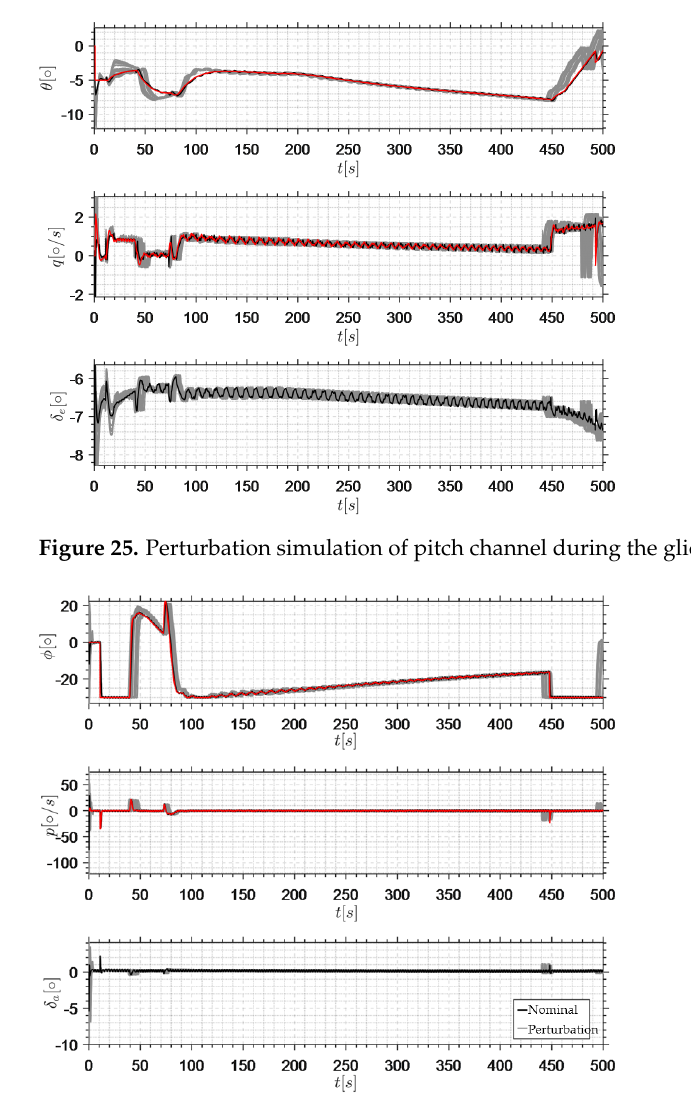
Figure 24. Perturbation simulation of lateral position during the mission.